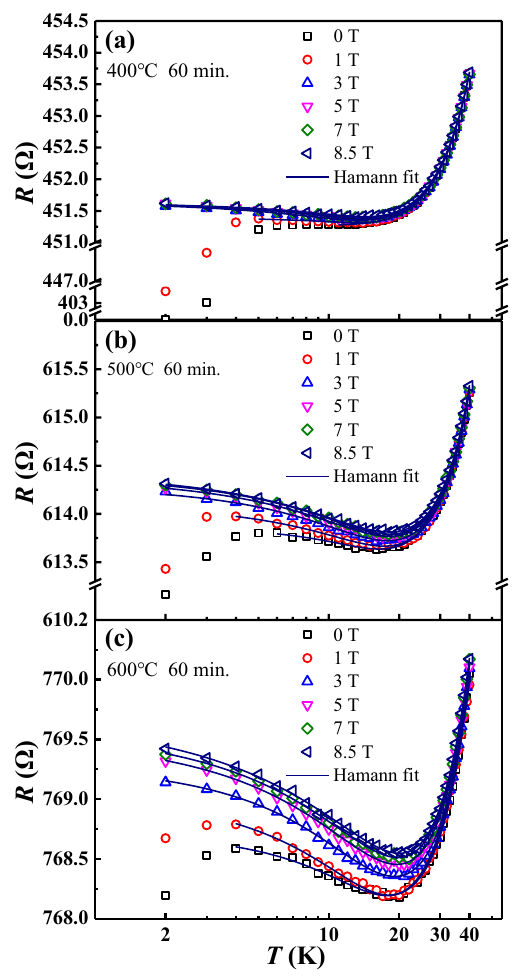
Figure 2. The effects of magnetic field on the R – T for Nb samples co-annealed at ( a ) 400 ◦ C, ( b ) 500 ◦ C, and ( c ) 600 ◦ C. The annealing time is 60 min. for all. The magnetic field ranges from 0 to 8.5 T. The room- temperature resistance R for the three samples: ( a ) 532.9 (cid:31) , ( b ) 688.1 (cid:31) and ( c ) 861.7 (cid:31) , respectively. The solid lines are the fitting curves for the Hamann theory. Note that the x -axes are in logarithmic